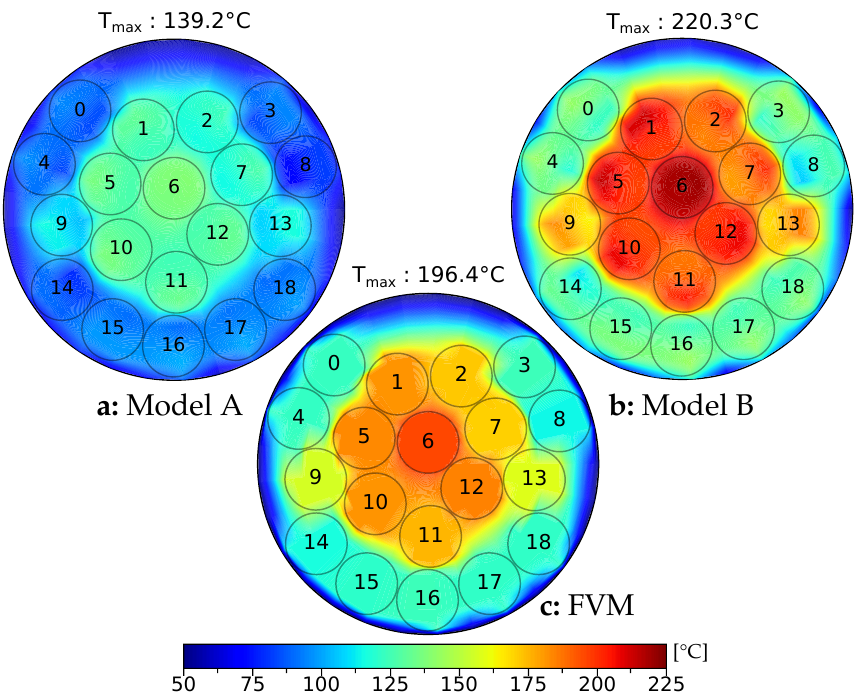
Figure A4. Comparison of thermal contours for round shape with a random layout between method A ( a ), method B ( b ) and FVM ( c ). Results data from Table